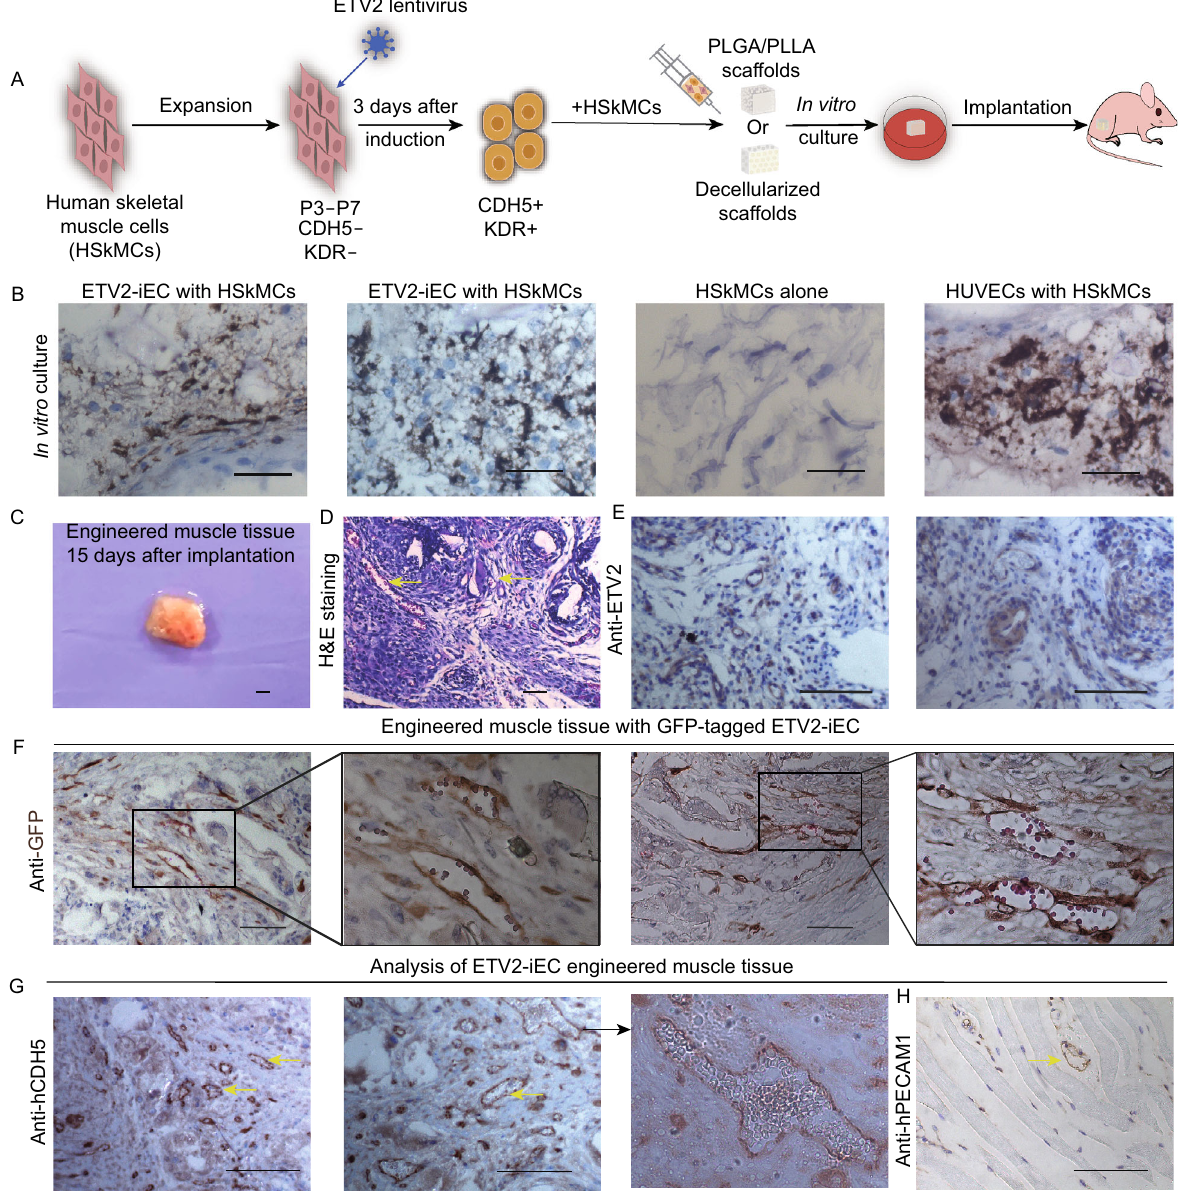
Figure 2. Analysis of engineered muscle tissue with ETV2-iEC on PLLA/PLGA scaffolds . (A) Experimental design for muscle tissue engineering with ETV2-iEC. (B) Analysis of engineered muscle tissue with ETV2-iEC on PLLA/PLGA scaffolds in vitro . DAB staining of CDH5 showed vessel-like structure formation after in vitro culture with ETV2-iEC or with HUVECs, while HSkMCs alone had no staining signal. (C – H) In vivo analysis of engineered muscle on PLLA/PLGA scaffolds. (C) Engineered tissue dissected out from nude mice 15 days after implantation. (D) H & E staining. (E) Immunostaining against ETV2 traced ETV2 expression. (F) Rabbit GFP mAb showed that some GFP-ETV2 infected cells were placed around vessels and harbored oval biconcave blood cells in engineered muscle. By brief eosin staining for one second, red blood cells could be stained as red, distinct from the brown signal of DAB. Immunostaining against human CDH5 (G) and human PECAM1 (H). Yellow arrows indicate vessel structures and black arrow indicates blood cells in magni fi ed views. Scale bars: 100 μ